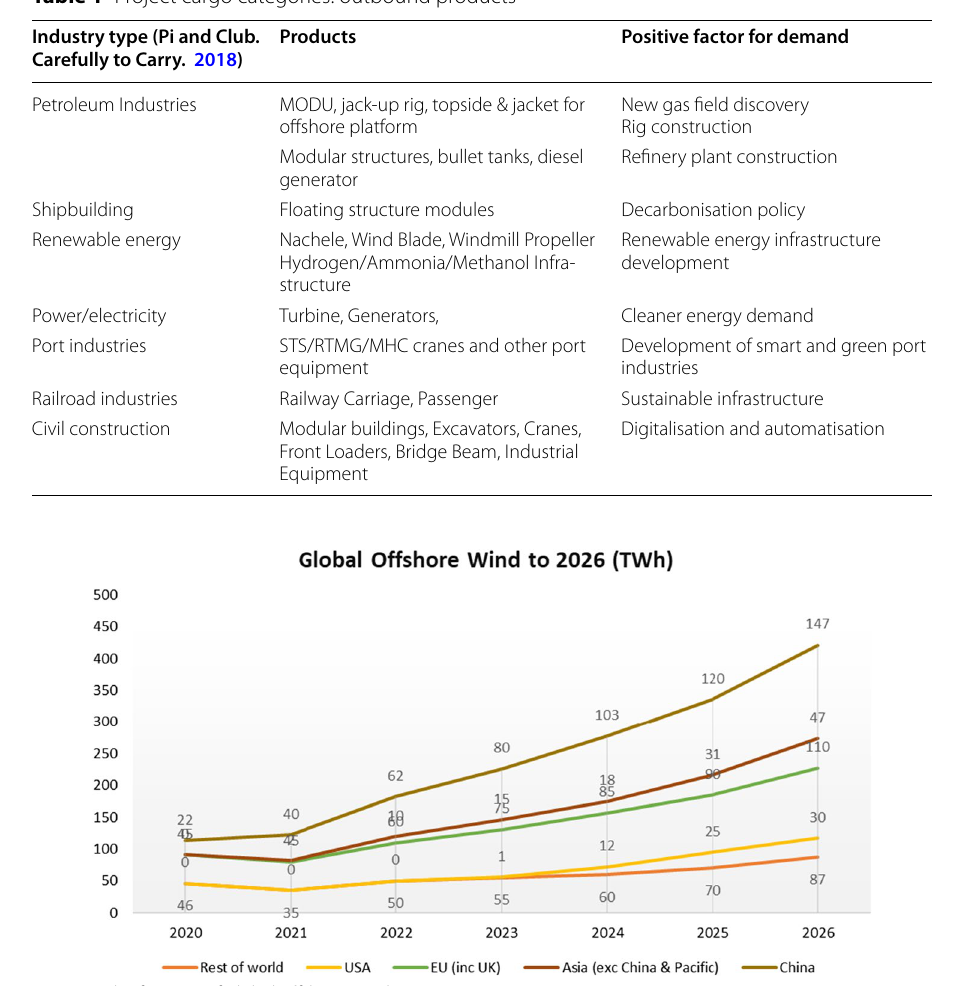
Fig. 1 The forecast of global offshore wind to 2026 (Drewry. 2022